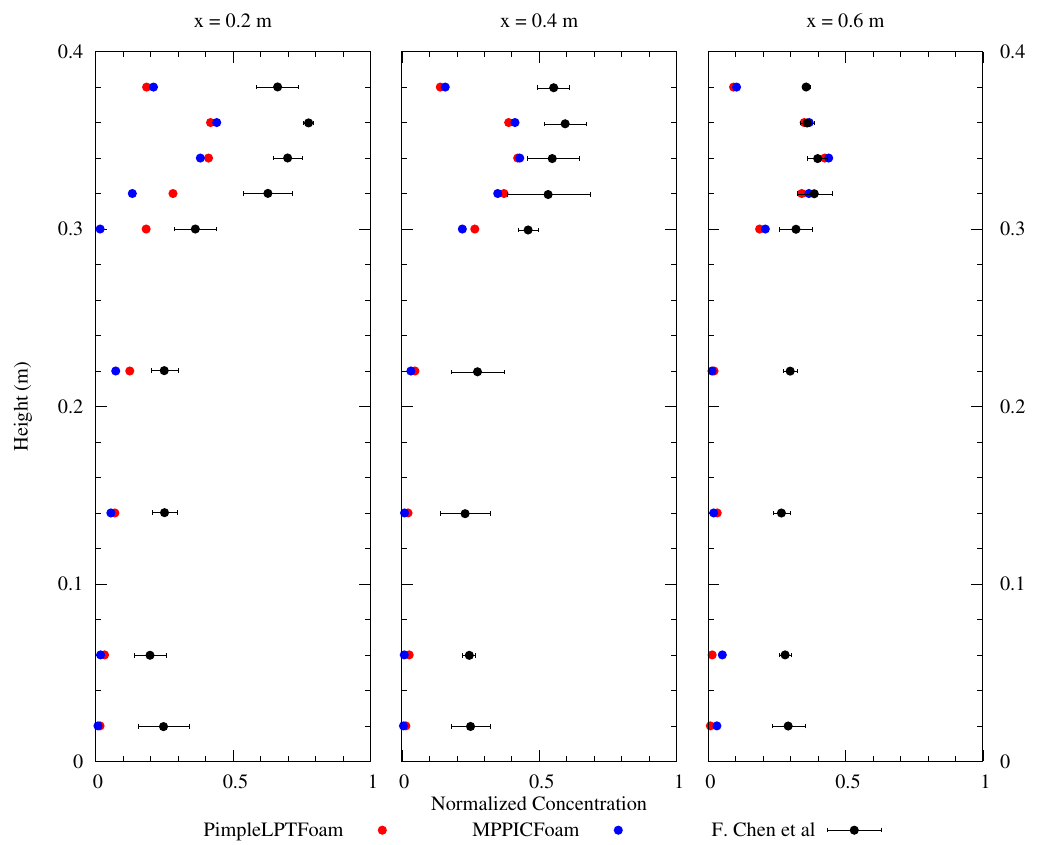
Figure 8. Comparison of measured and simulated particle concentrations with data from the experiment of [42]. The particle concentration values were normalized with the measured particle concentrations at the inlet of the test room or the computational domain. For the simulations with the two solvers PimpleLPTFoam and MPPICFoam , particle concentrations were computed as the time average of 1800 s simulation time. Experimental data from [42], Elsevier,